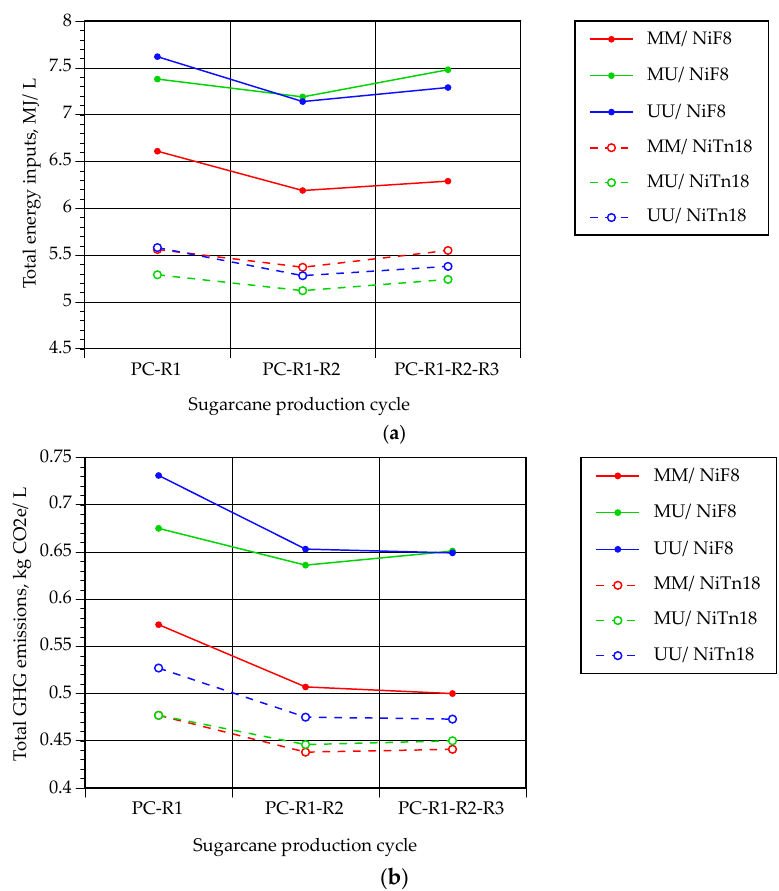
Figure 4. Sensitivity analysis of total energy inputs ( a ) and total greenhouse gas (GHG) emissions ( b ) to the number of ratoons. PC-R1, a plant cane and one ratoon; PC-R1-R2, a plant cane and two ratoons; PC-R1-R2-R3, a plant cane and three ratoons (the default scheme). MM, mulching at planting and every ratooning; MU, mulching only at planting; UU, untreated, i.e., no mulching at all. NiF8, a conventional cultivar; NiTn18, a cultivar characterized by improved yielding capacity and cold tolerance.